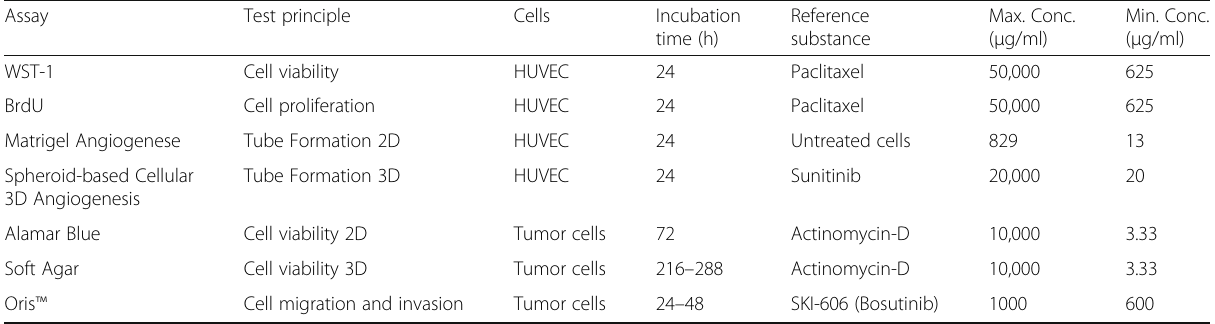
Table 1 Overview of the assays used to evaluate the therapeutic potential of HNE